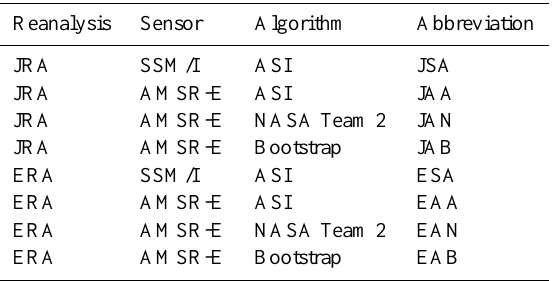
Table 1. Abbreviations used for the different combinations of re- analyses and ice concentration data